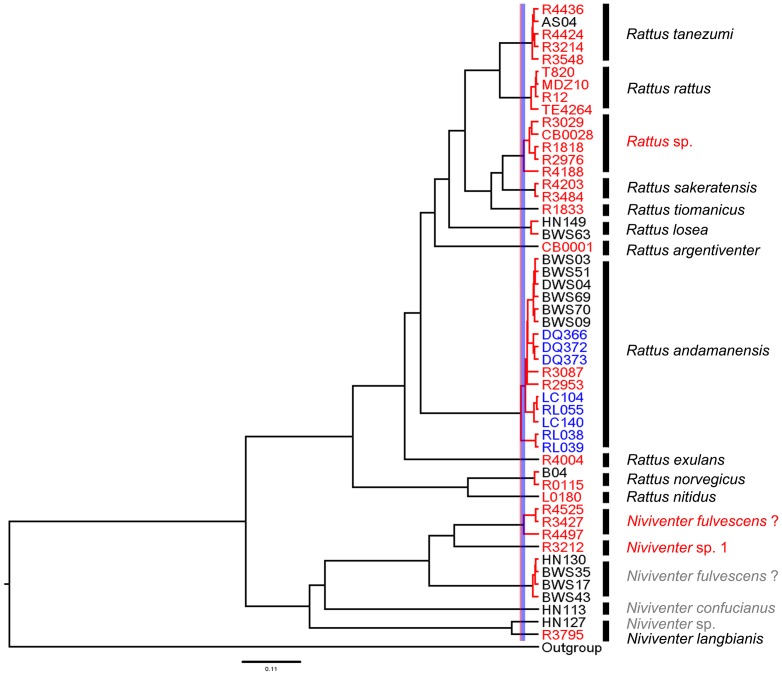
Ultrametric tree of Rattus and Niviventer species from Hainan, Yunnan and Southeast Asia based on the combined Cyt-b and COI dataset.Red clusters of specimens were recognized as putative species by the method of Pons et al. [19]. The blue shadow on the tree indicated the confidence interval of the threshold, and the red vertical line was the threshold point obtained from the GMYC model. The meaning of different colors of samples names is the same as in the Figure 3. The black species names were confirmed species names in published papers and this paper; the red and gray species names means they were not confirmed in published papers and this paper.